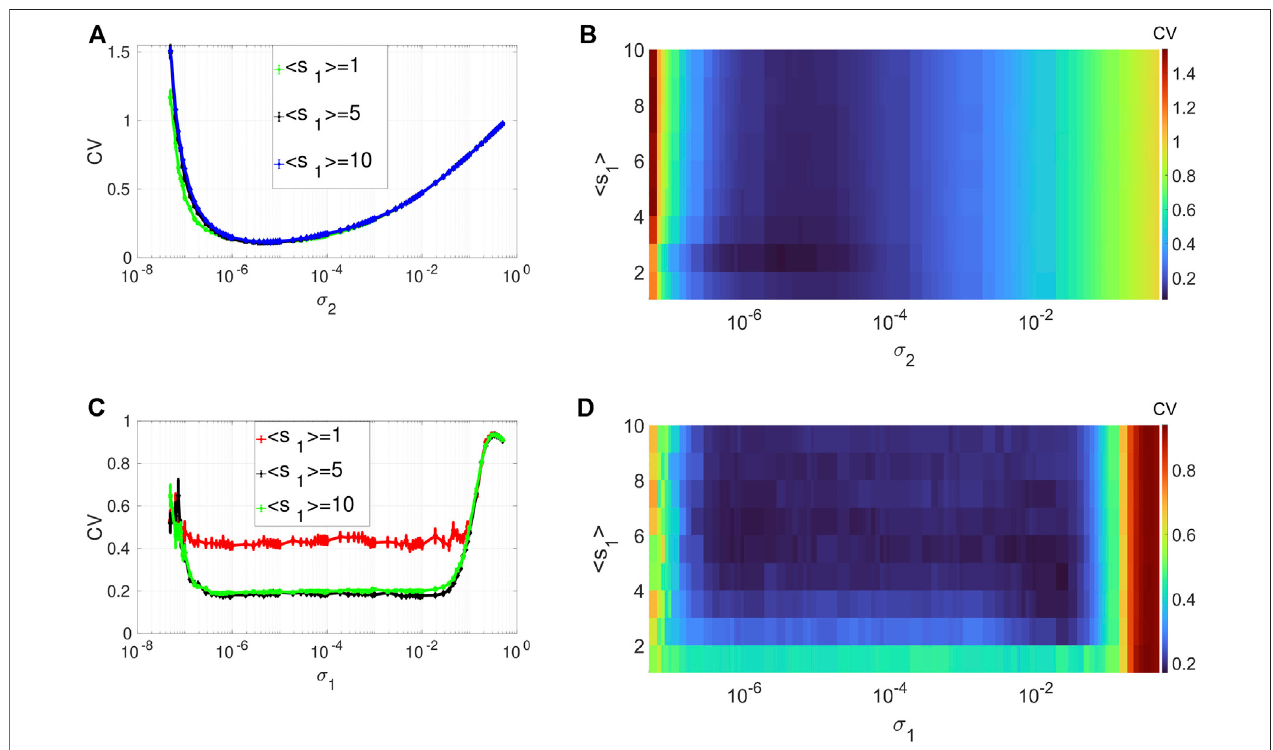
FIGURE 2 | Variation of CV w.r.t. the average degree 〈 s 1 〉 and the noise intensity σ 2 for CR or σ 1 for SISR. Panels (A) and (B) show CR characterized by a family of non-monotonic CV curves w.r.t.